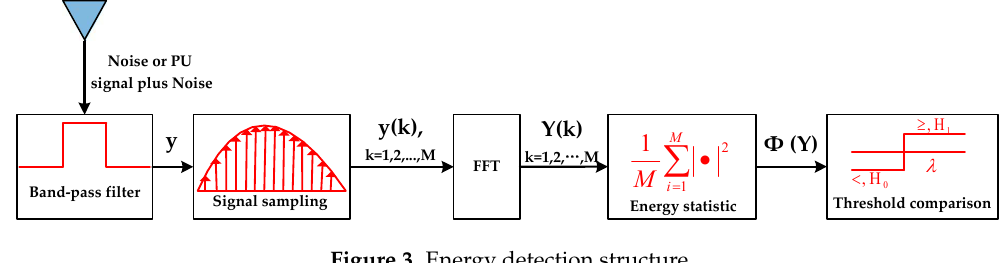
Figure 3. Energy detection